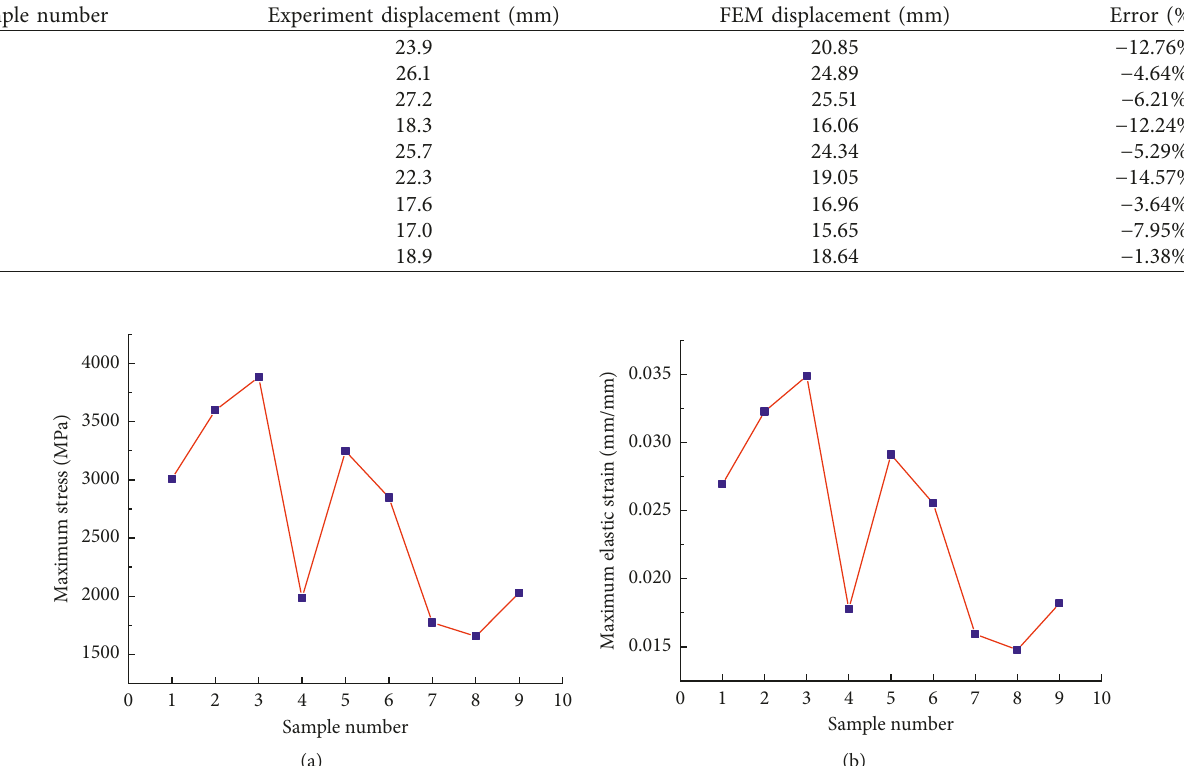
Table 8: Low-speed impact displacements of samples.